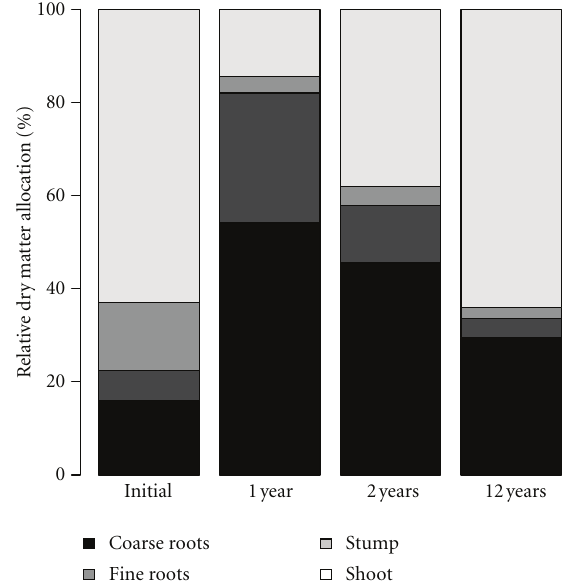
Figure 4: Relative dry matter distribution of the woody biomass compartments shoot , stump , fine roots, and coarse roots of seedlings (Initial), a one-, two-, and a 12-year-old stand of black locust ( Robinia pseudoacacia